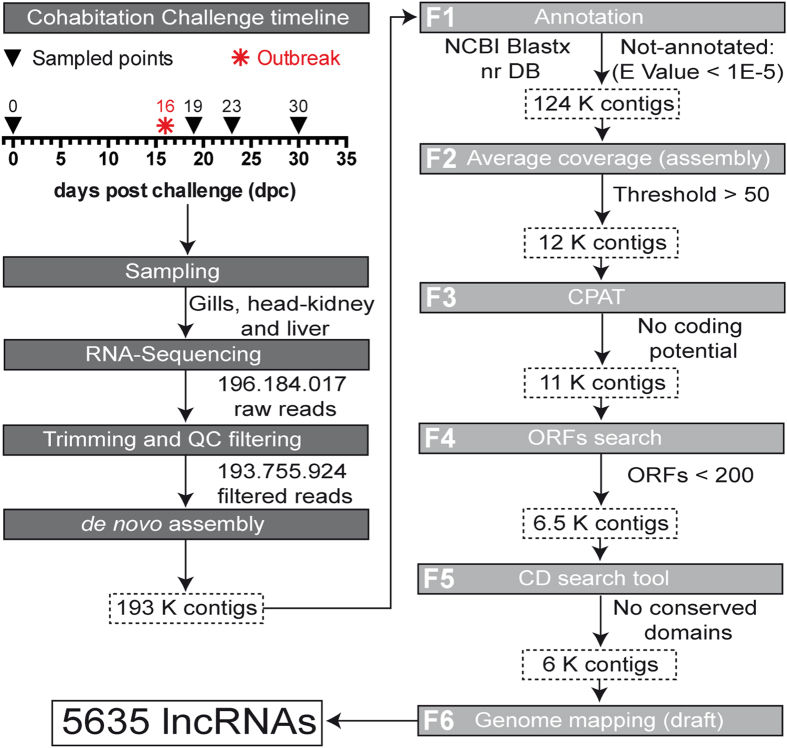
Overview of lncRNA identification process.Outline of computational pipeline and systematic workflow used for discovering specific long non-coding RNAs.